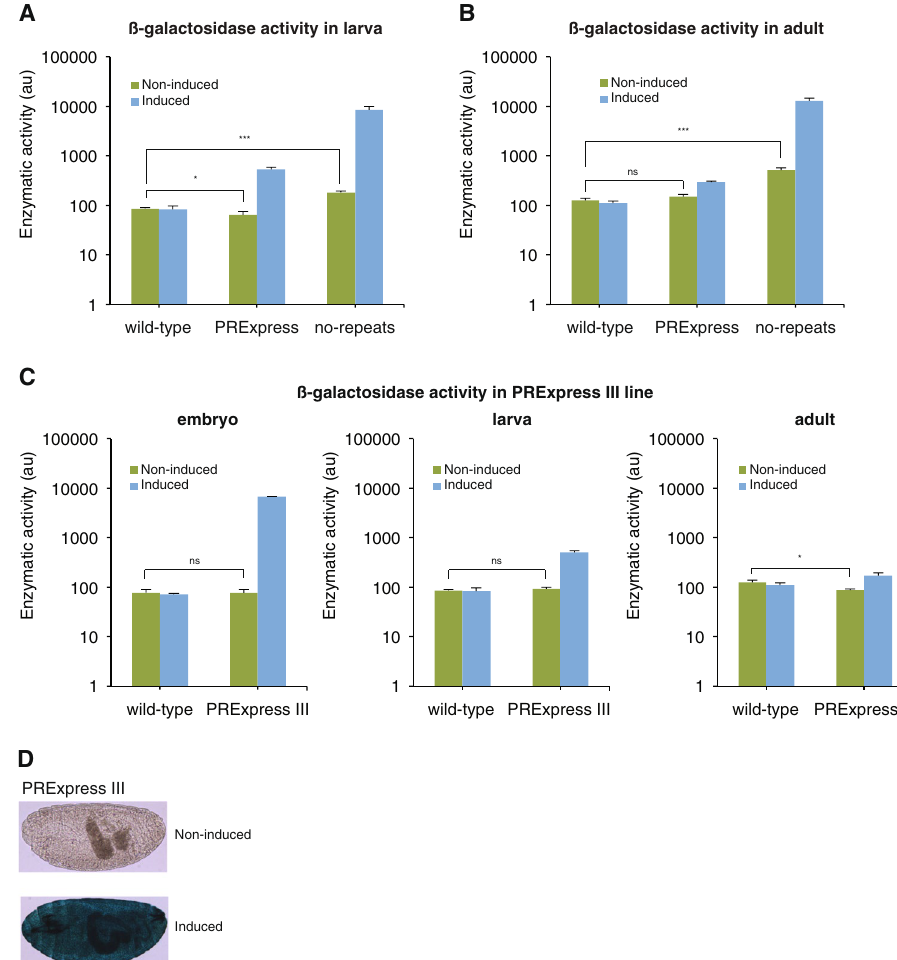
Figure 3. PRExpress in larva, adult, and at 3 rd chromosome integration site. ( A ) β -galactosidase activity of larval protein extracts. In the non-induced state, no-repeats control showed 2-fold higher activity levels than wild-type, while PRExpress showed lower levels than wild-type. Upon induction, PRExpress and no-repeats showed increased activity levels, with activity of no-repeats extract higher than PRExpress. ( B ) β -galactosidase activity of adult fly protein extracts. In adult flies, no-repeats showed 4-fold higher activity in the non-induced state, while PRExpress was not significantly different from wild-type. In induced state, no-repeats showed a strong increase in activity, while PRExpress showed only 2-fold increase. ( C ) β -galactosidase activity of embryonic, larval, and adult fly whole protein extracts from wild-type and PRExpress III lines. There was no evidence of leakiness in the non-induced state. The β -galactosidase activity in PRExpress III adults was lower than in wild-type adults. Upon induction, PRExpress III line showed similar increases in activity as PRExpress line. ( D ) X-gal staining of non-induced and induced PRExpress III embryos. Statistical significance of comparisons between non-induced and induced wild-type, PRExpress, no-repeats, and PRExpress III samples in Fig. 3A–C is given in Supplementary Table 1. NS – P > 0.05, * P ≤ 0.05, ** P < 0.01, *** P < 0.001, n =